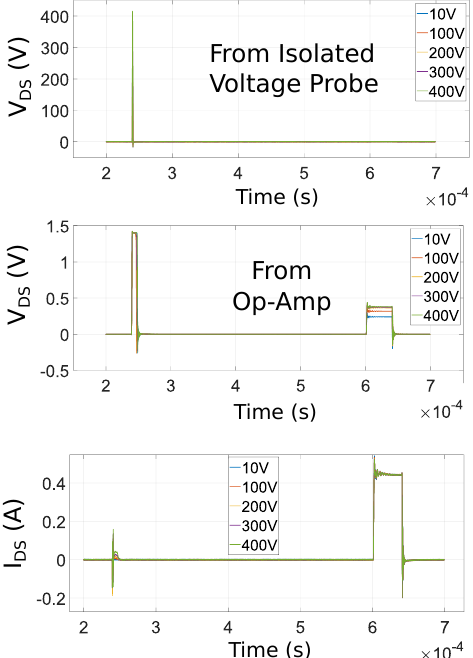
Figure 8. V DS and I DS DUT waveforms acquired by the scope for ∆ T M = 400 µ s. From waveforms as the ones described in Figures 7 and 8, R ON = V DS / I DS is computed for different ∆ T M . The trends of the R ON as a function of the blocking voltage evaluated at ∆ T M = 20 µ s, ∆ T M = 100 µ s and ∆ T M = 400 µ s are plotted in Figure 9, where the normalization factor is the value at V block = 0 V for all cases. The observed degradation